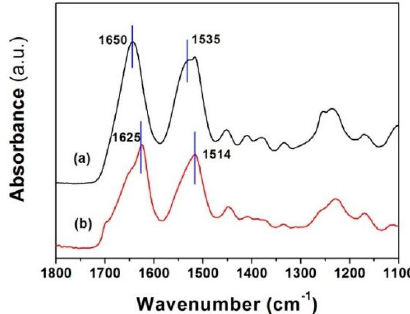
Figure 8. Fourier transform infrared spectroscopy (FTIR) spectra for SF-SELP core-shell fiber mats before and after methanol vapor treatment: ( a ) before methanol vapor treatment; and ( b ) after methanol vapor treatment.